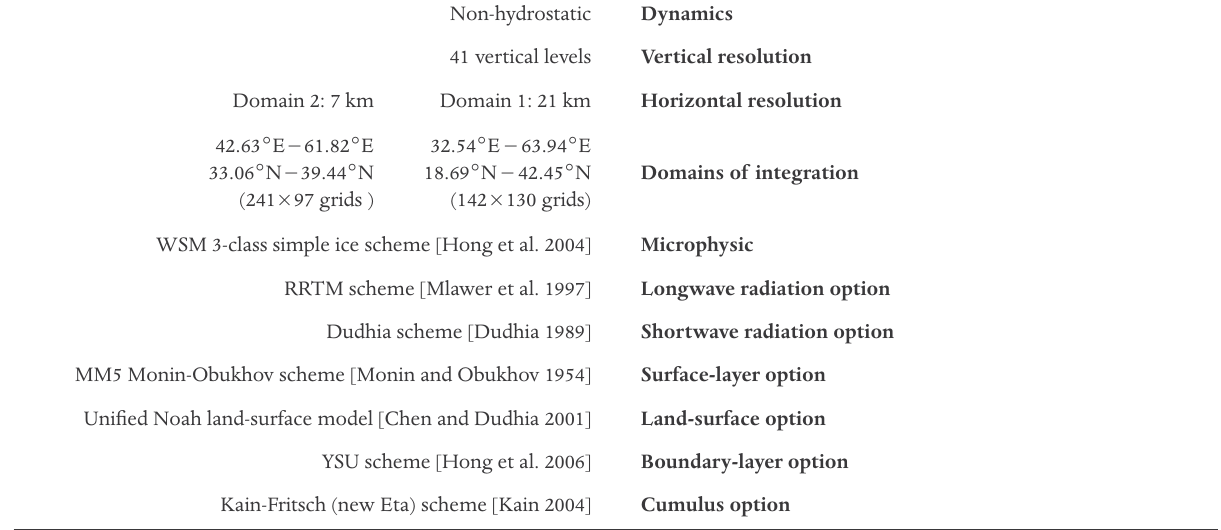
Table 1. Details of domains and physics used in the